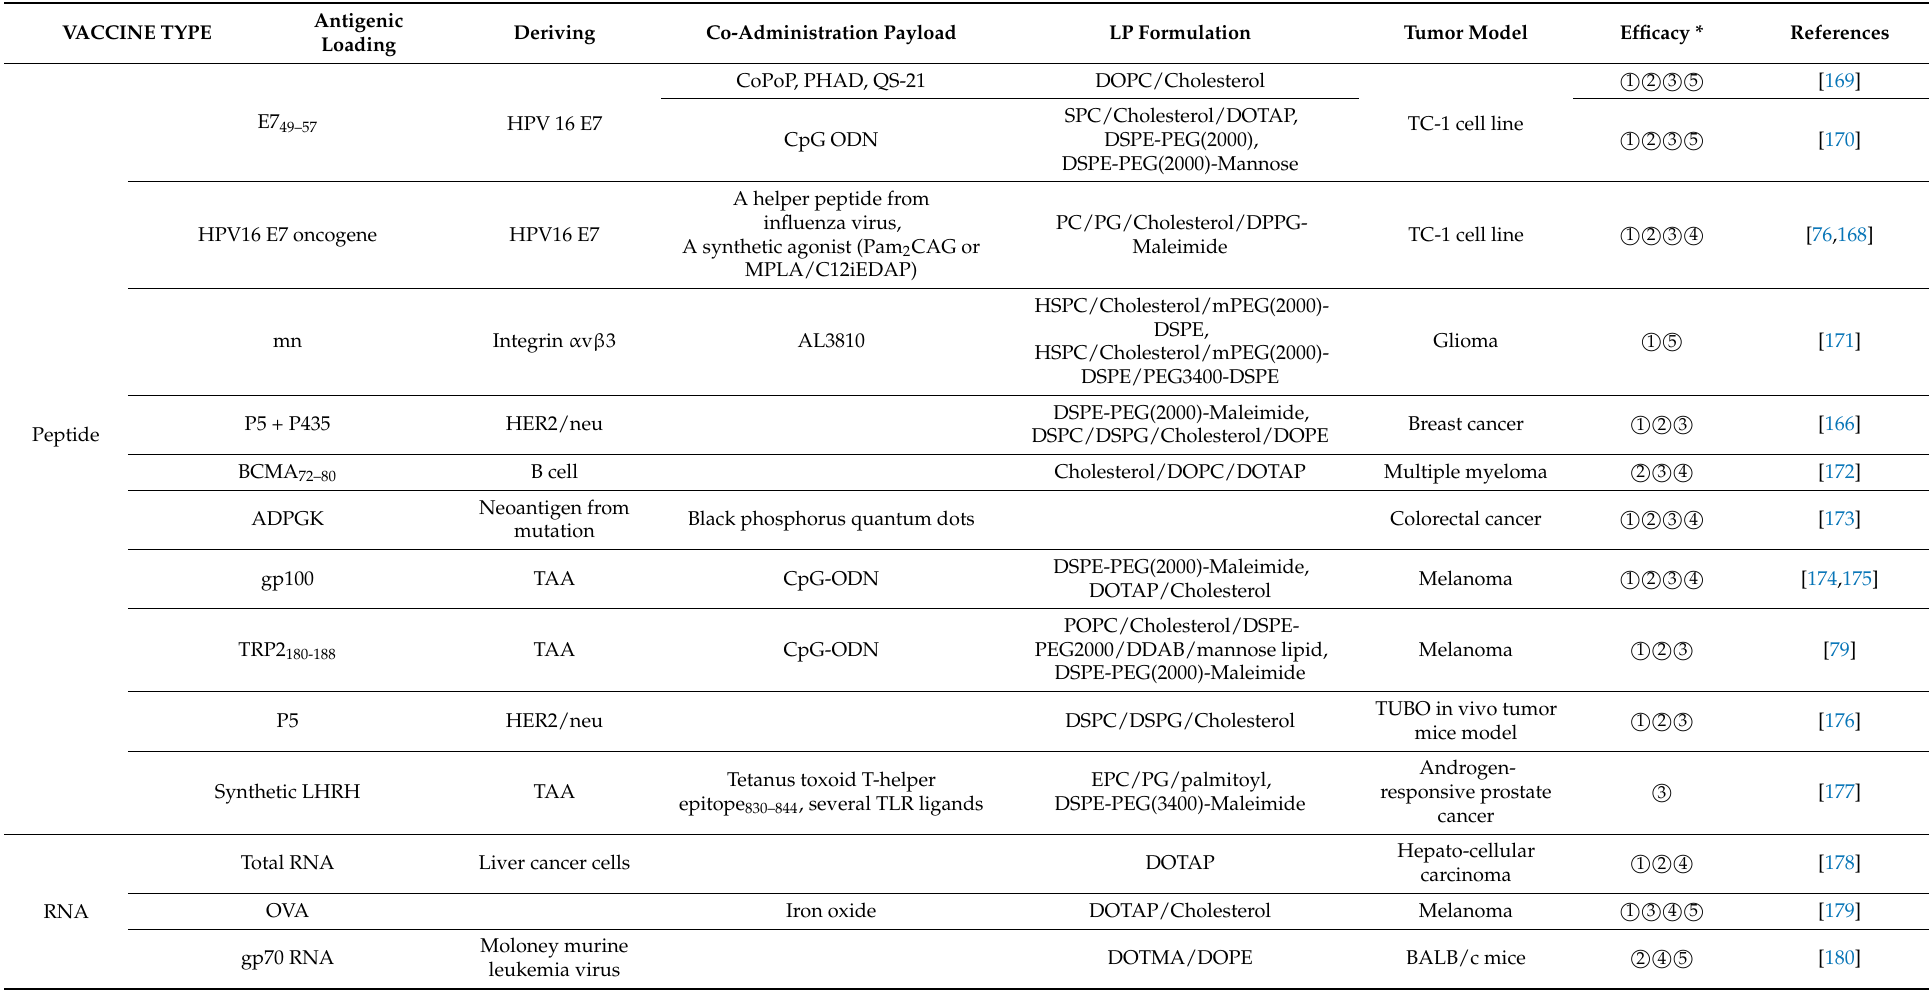
Table 3. Notable applications of cancer vaccines in the last five